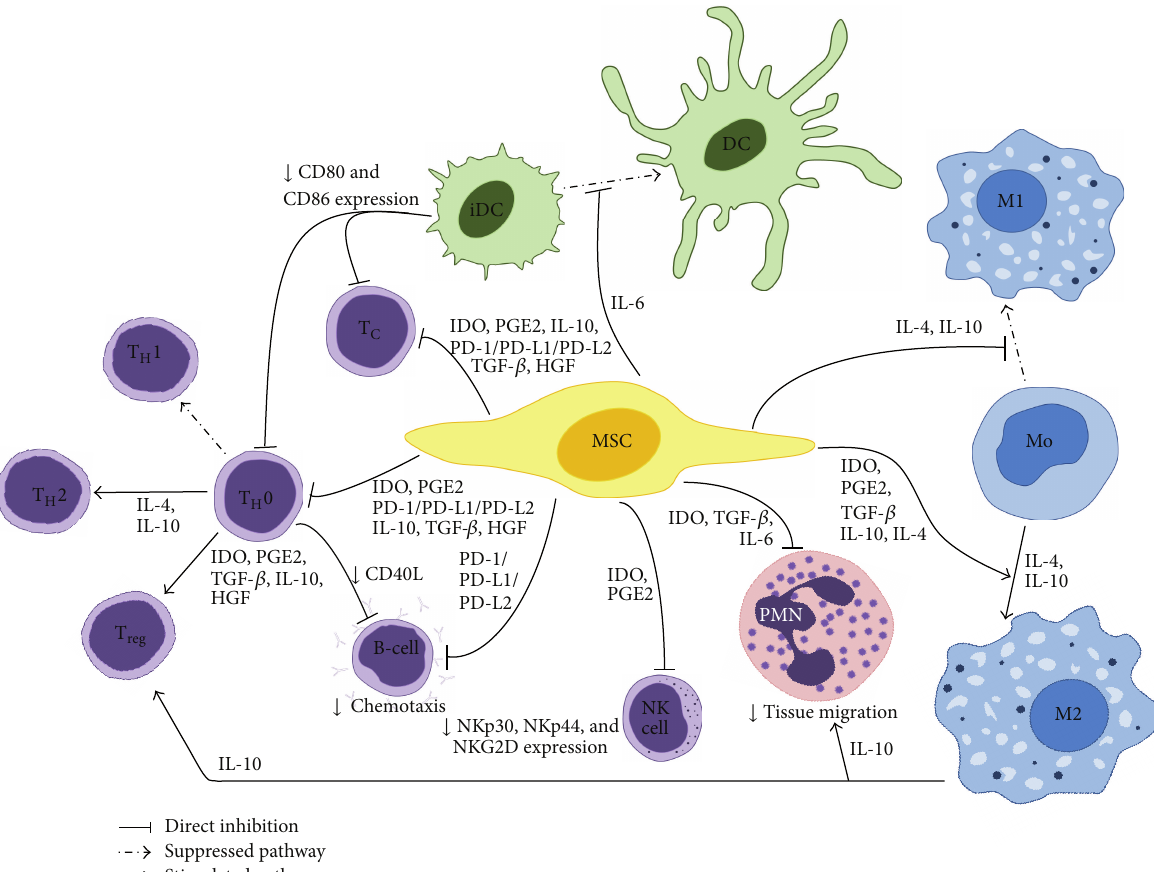
Figure 1: Schematic overview of the interactions between MSC and the immune system. Mesenchymal stem cells influence the functioning of ) and cytotoxic T-cells (T ). In addition, many immune cells. Via multiple possible pathways MSC suppress proliferation of both helper (T H C ) is triggered, resulting in an anti-inflammatory environment. Maturation of immature 2 and regulatory T-cells ( T differentiation to T H reg dendritic cells (DC) is inhibited via IL-6, blocking upregulation of CD40, CD80, and CD86, which in turn can reduce T-cell activation. Monocytes are triggered by MSC to differentiate towards the M2 phenotype. Different mechanisms appear to be involved in this process, amongst which IDO, TGF- 𝛽 , IL-10, and PGE2 are the most important ones. IL-10 produced by these M2 macrophages can boost the formation , while reducing tissue migration of neutrophils. Neutrophils (polymorphonuclear granulocytes; PMN) are allowed a longer life span of T reg by MSC-derived IL-6, while ROS production is decreased. Natural killer cell (NK cells) proliferation is suppressed, as well as cytotoxic activity and cytokine secretion. B-cell proliferation is inhibited and the production of antibodies is